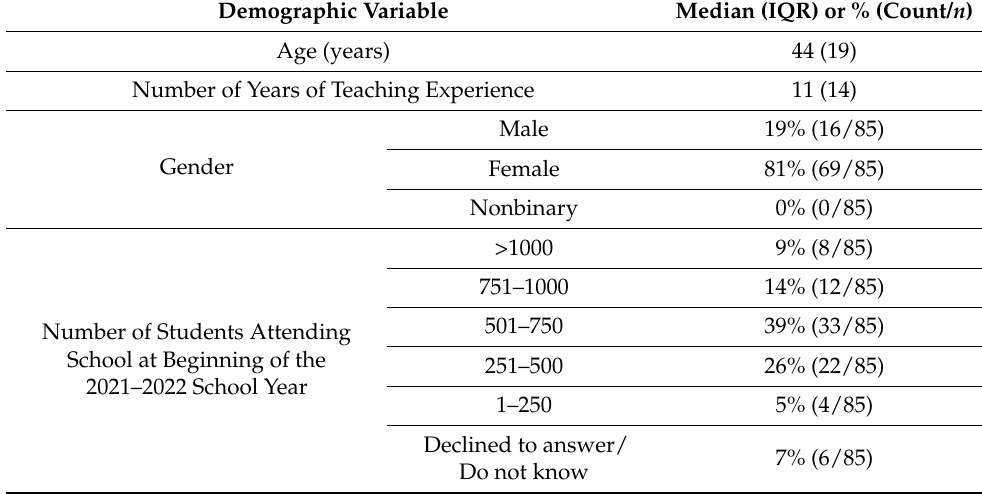
Table 1. Participant demographics, teachers’ perception of COVID-19 in the workplace, and